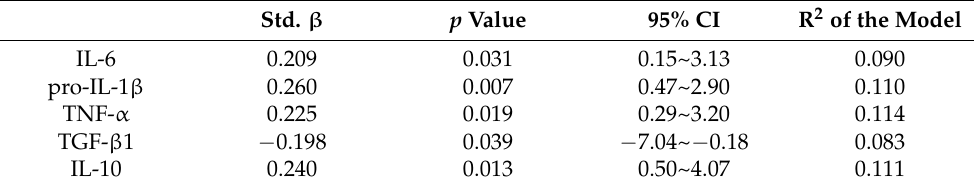
Table 4. Association of plasma extracellular vesicle cytokine levels with the presence of Parkinson’s disease cognitive deficit (Mini-Mental state Examination (MMSE) less than 26) after adjustment for age and